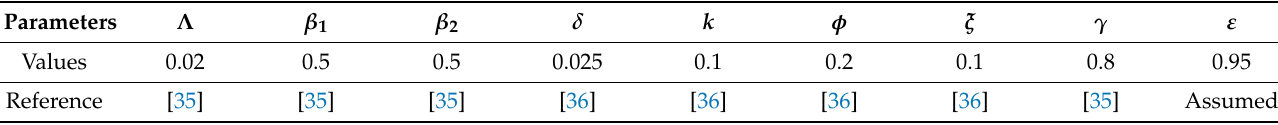
Figure 3. Time series of system (3) corresponds to Table 3 when E 1 = ( 0.1254,0.0519,0.5429,0.0783 ) and R 0 = 1.6246. Table 5. Parametric values used in system (3) when β 1 = β 2 , E 1 = ( 0.0567,0.0572,0.5984,0.0864 ) and R 0 = 2.2154.